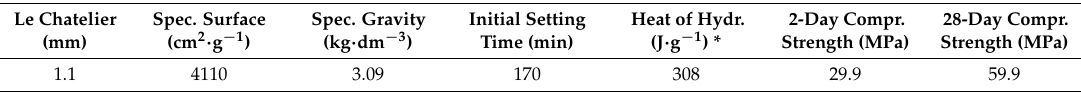
Table 2. Physical properties of cement CEM I 42.5 R.